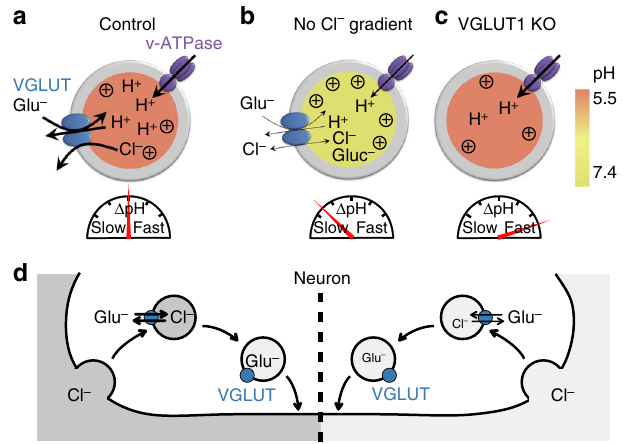
Fig. 9 Model for VGLUT transport mechanism and SV re-acidi fi cation. Luminal pH is indicated by the green-red scale. Re-acidi fi cation rates are represented by a speedometer. Strength of ΔΨ is symbolized by (+). a In presence of high luminal Cl − , ef fl ux of Cl − facilitates glutamate uptake by generating ΔΨ . The glutamate/Cl − exchange mechanism allows an electroneutral SV fi lling without increasing the osmotic pressure. As the luminal Cl − concentration gradually decreases, glutamate uptake is driven by the ΔΨ generated by the V-ATPase. Glutamate transport fi nally stops when ΔΨ vanishes and luminal pH decreases. b In absence of a permeant anion in the vesicular lumen (e.g. Gluc − or MeS − ), glutamate uptake is fuelled solely by the V-ATPase and is limited by the osmolarity. The overall process of loading and acidi fi cation is slow. Additionally, if Gluc − is used as a substitute for Cl − , its buffering capacity prevents luminal acidi fi cation in presence of high HEPES concentrations. c In absence of VGLUT, acidi fi cation is strongly accelerated. KO knockout, Glu − glutamate, Gluc − gluconate, MeS − methanesulfonate. d Illustration of glutamate loading at synaptic terminal during recycling of SV. During endocytosis, Cl − is engulfed inside SV from the extracellular space. The anion is subsequently exchange for glutamate through VGLUT. Left: high Cl − concentration,